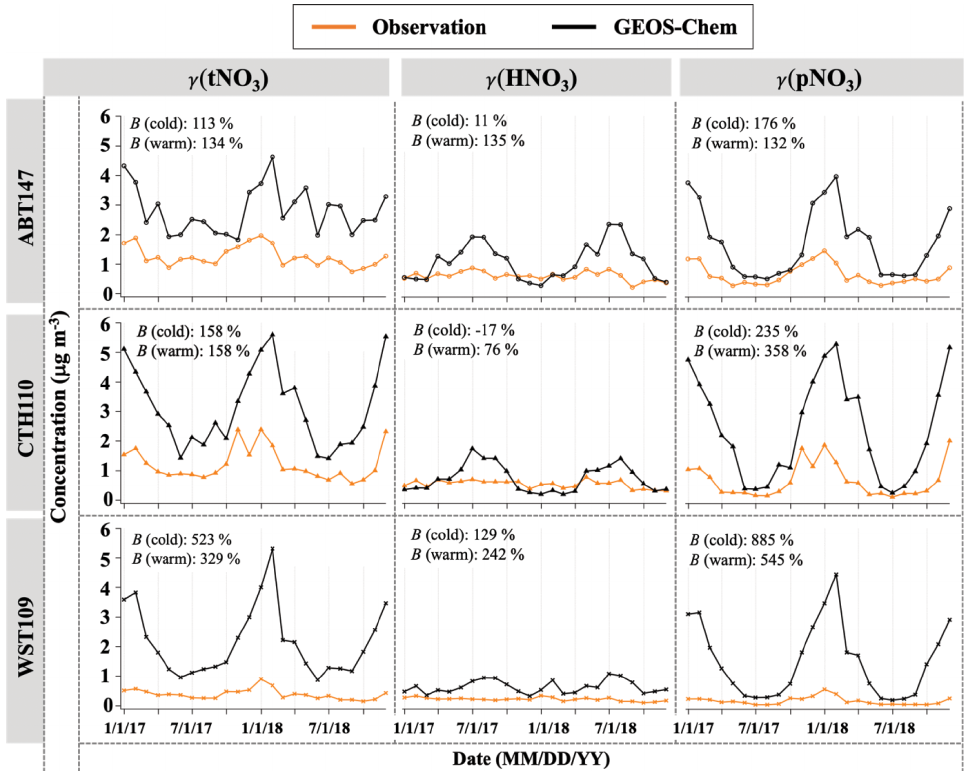
Figure 3. Time series of monthly mean total nitrate, HNO 3 , and pNO 3 concentrations ( γ ) observed and simulated at ABT147, CTH110, and WST109 CASTNET sites. B refers to the normalized mean bias for comparison of the model to observations (see Sect. 2.3 in Methods).